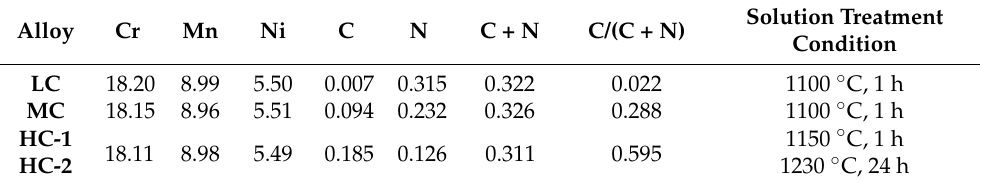
Table 1. The chemical compositions were measured using optical emission spectroscopy (QSN 750-II, PANalytical, Almemo, The Netherlands). Table 1. Chemical compositions (wt%) and solution treatment temperatures of the investigated